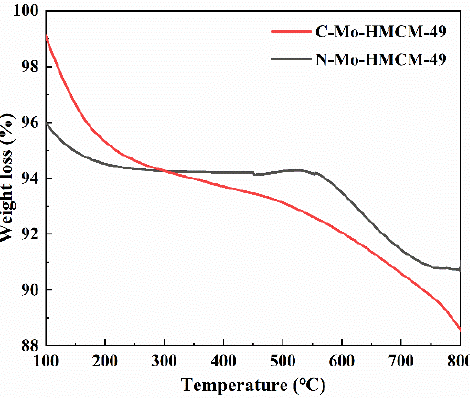
Figure 14. TG curves of C-Mo-HMCM-49 and N-Mo-HMCM-49 reaction for 430 min.